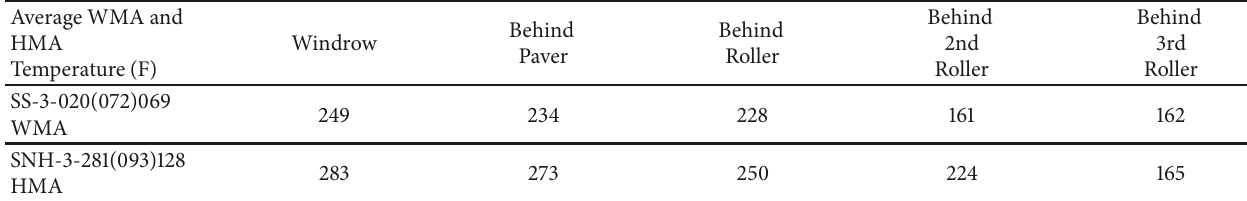
Table 2: Average WMA and HMA temperature during different pavement process operations in